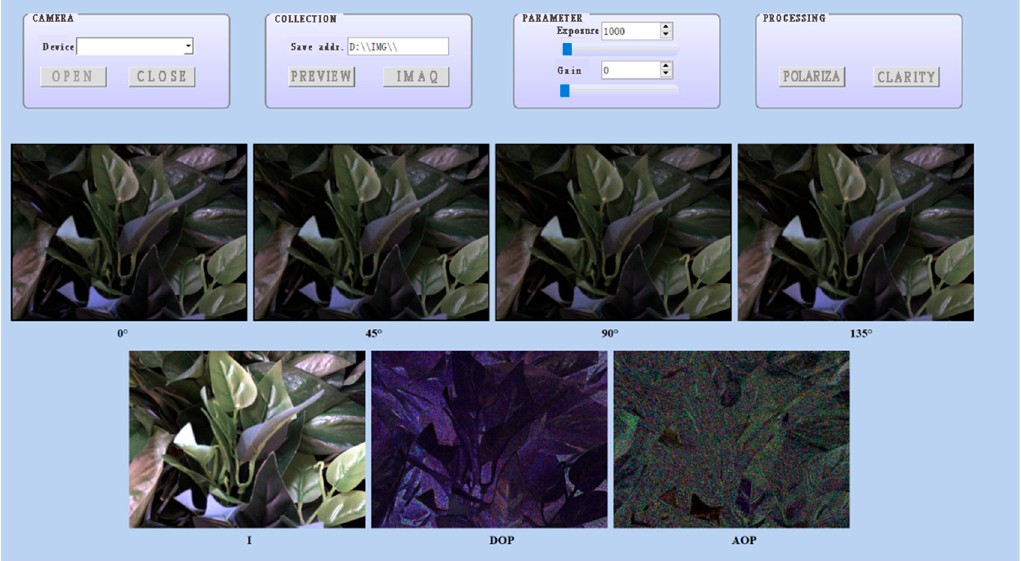
Figure 4. Flow chart of polarization imaging software system.